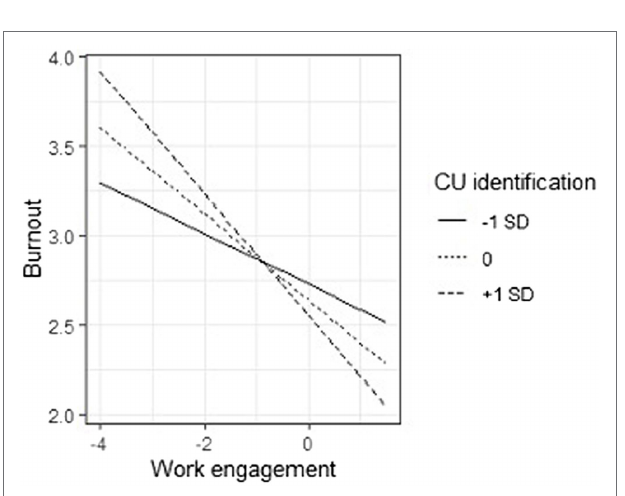
FIGURE 4 | Interactions between CU identification and Work engagement on Psychological distress.